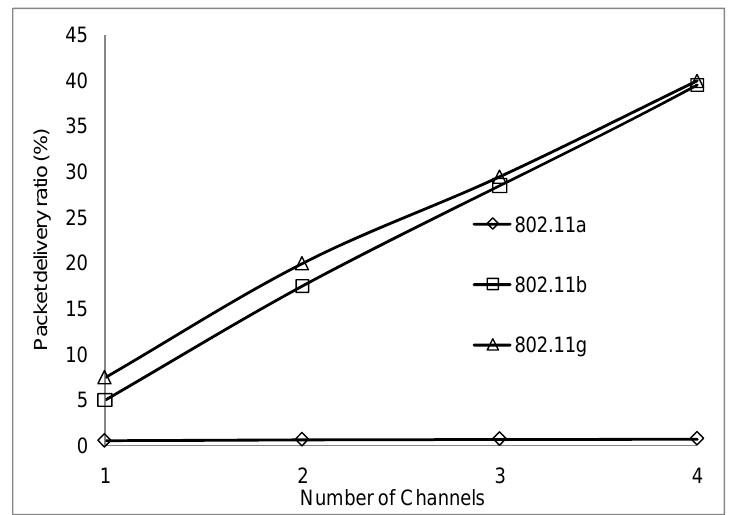
Figure 31. Delivery ratio at 100 m range and data rate of 2 Mbps.